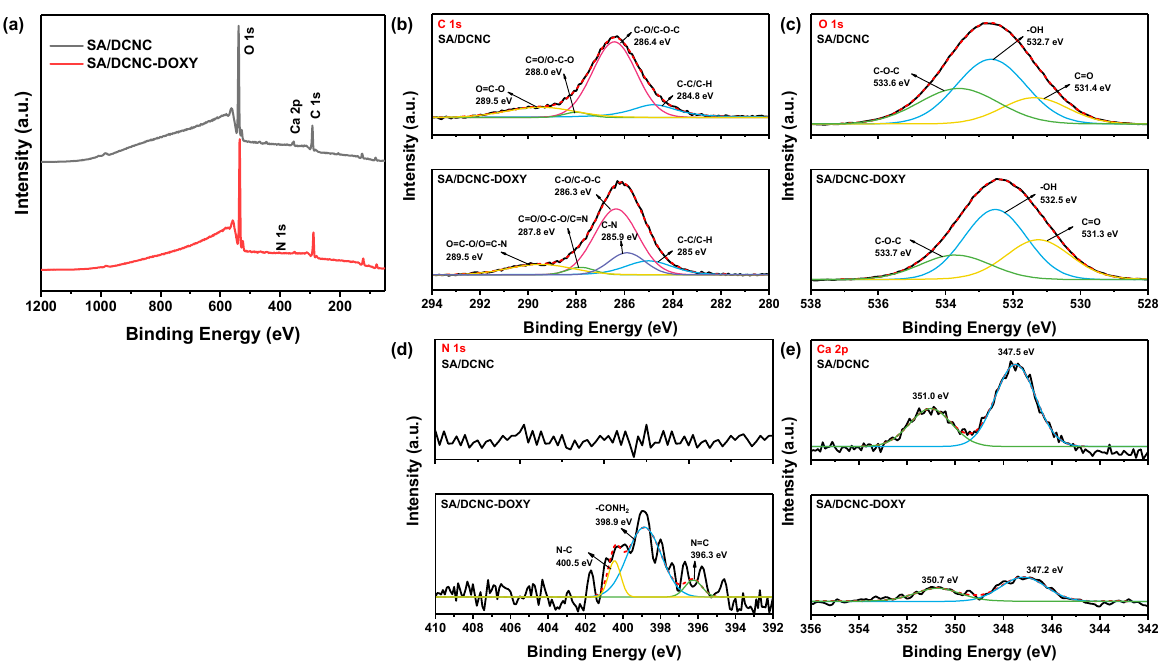
eV (Figure 12b), corresponding to C ‐ C/C ‐ H, C ‐ O/C ‐ O ‐ C, C=O/O ‐ C ‐ O, and O ‐ C=O bonds, respectively [51]. After adsorption, the C 1s spectrum of SA–DCNC was deconvoluted into five peaks at 285, 285.9, 286.3, 287.8 and 289.6 eV, where the new peak at 285.9 eV can be assigned to the C ‐ N groups in DOXY [52] and the shifts of the existing peaks suggest interaction between DOXY and SA–DCNC. The high ‐ resolution O 1s spectrum of SA–DCNC revealed three peaks at 531.4, 532.7, and 533.6 eV (Figure 12c), which can be assigned to the binding energy of C=O, ‐ O ‐ H, and C ‐ O ‐ C, respectively [53]. After DOXY adsorbed onto SA–DCNC, the area of the C=O peak increased from 19.3% to 30.3%, which can be attributed to the carbonyl groups presented in the loading DOXY molecules. The high ‐ resolution N 1s spectrum of SA–DCNC ‐ (Figure 12d) was deconvoluted into three peaks at 396.3, 398.9, and 400.5 eV, corresponding to N=C, ‐ CONH 2 , and N ‐ C, respectively [46,54]. The ‐ CONH 2 and N ‐ C peaks were from the adsorbed DOXY molecule, while the N=C peak confirms the formation of imine groups between DCNC and DOXY. The Ca 2p XPS spectrum of SA–DCNC before adsorption was deconvoluted into two peaks at 347.5 eV (Ca 2p 3/2 ) and 351.0 eV (Ca 2p 1/2 ) [55]. After DOXY adsorption, the two peaks shifted to 347.2 eV and 350.7 eV, respectively, and their intensities showed a significant decrease. This change may be induced by the interaction between Ca 2+ and the oxygen or nitrogen atoms on doxycycline molecules, followed by an electron transfer from oxygen or nitrogen to Ca 2+ or the ion exchange during the adsorption process [19,53].